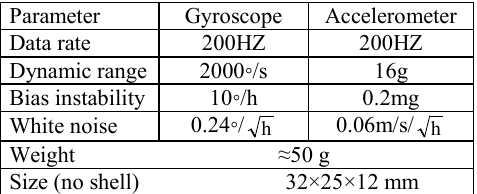
Table 2 . The Module Parameters of